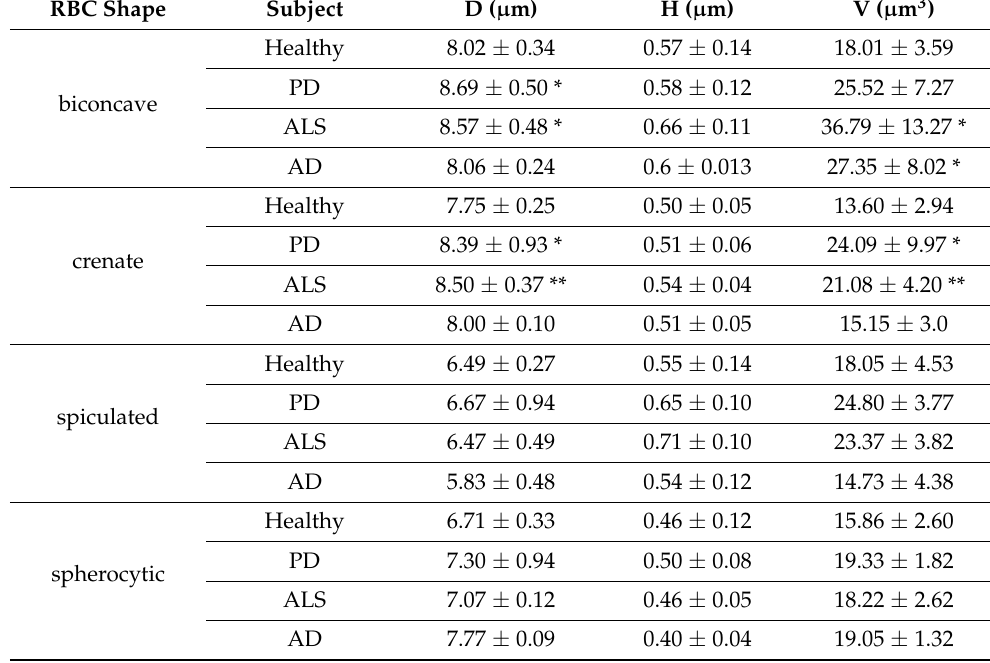
p values < 0.05 are denoted by * and p < 0.01 by